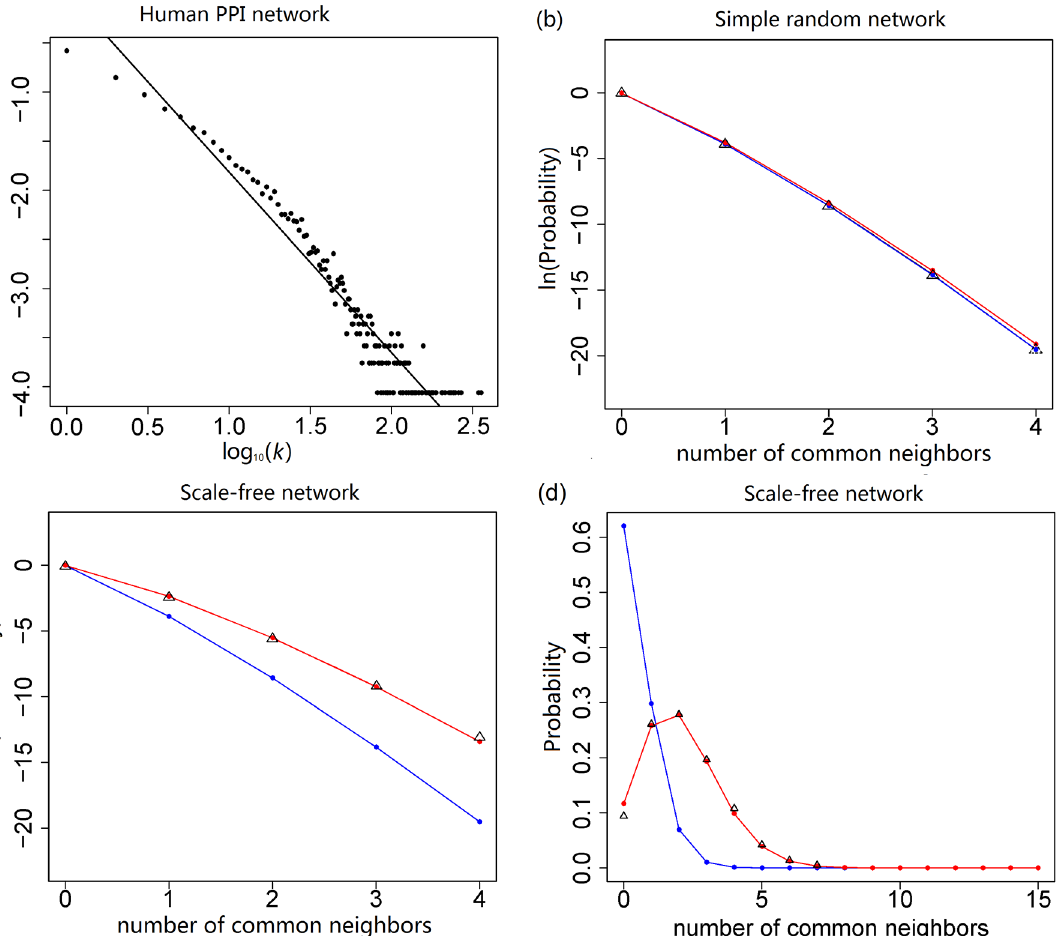
Fig 1. Comparison between the observed probabilities and the theoretical probabilities. ( a ) A human PPI network with n = 11,524 nodes and average degree of 9.0. The dashed line (fitted after log-log transformation) has a slope of -1.925 (the 95% confidence interval: [1.834, 2.016]) for the power-law tail (i.e., degree ( k ) (cid:1) 5). ( b ), ( c ) Performance comparison between formulas (1) and (2) in simple random networks (1000-time simulations) and scale-free networks (100-time simulations). The Black triangles represent the observed probabilities for the shared number of common neighbors, and the black dashed triangle represents the expected observation because m = 4 was not observed in ( b ). The red and blue points (lines) represent the theoretical probabilities calculated from formulas (1) and (2), respectively. Both ( b ) and ( c ) are examples with k A = 15 and k B = 16 as the degrees of protein A and B . ( d ) is also an example for scale-free networks, with k A = 77 and k B = 71 as the degrees of protein A and B , but without log-transformation of the probabilities ( y